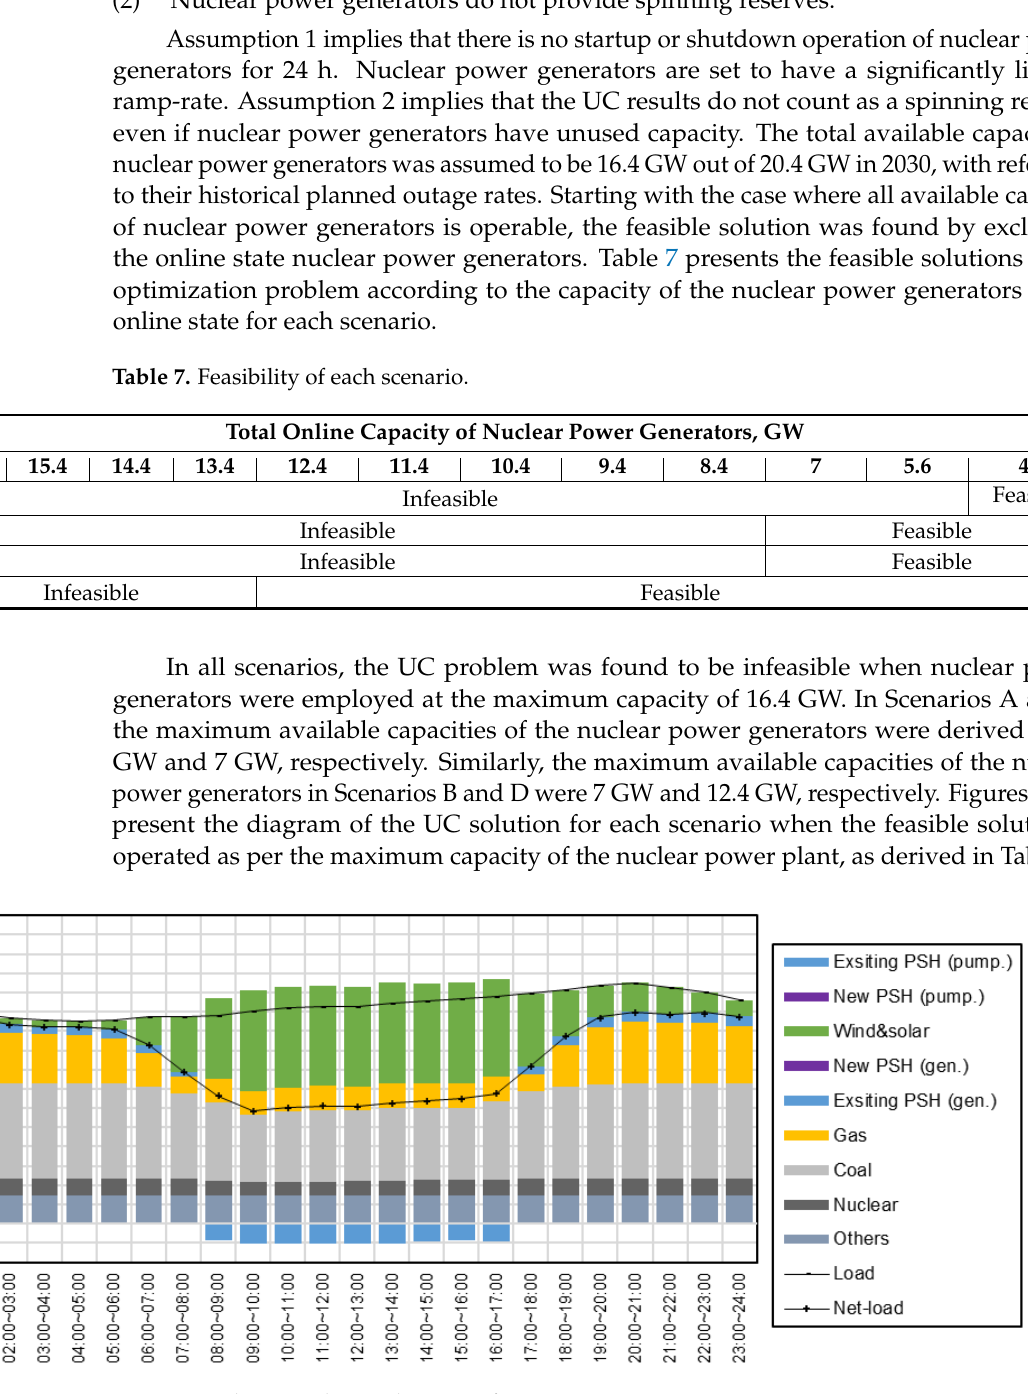
Figure 11. The UC solution diagram of Scenario A.